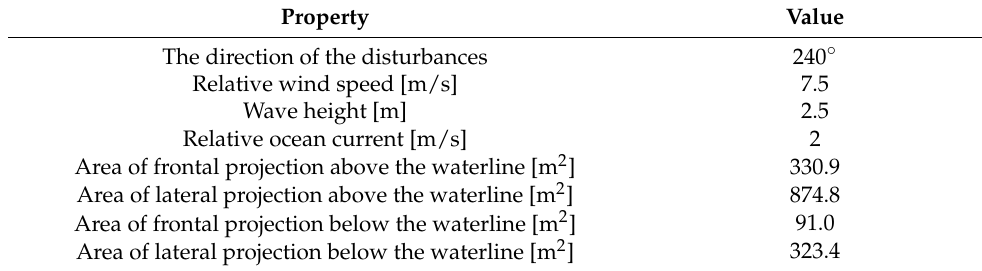
Table 3. Marine environment parameter